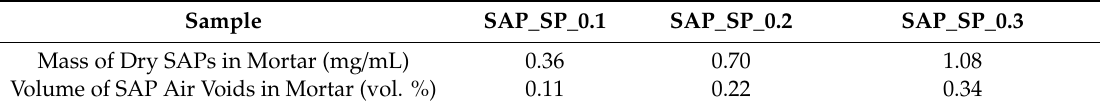
Table 5. Mass of dry SAP_SPs and volume of air voids formed by the SAP_SPs in a unit volume of mortar. Sample SAP_SP_0.3 Mass of Dry SAPs in Mortar (mg / mL) Volume of SAP Air Voids in Mortar (vol.